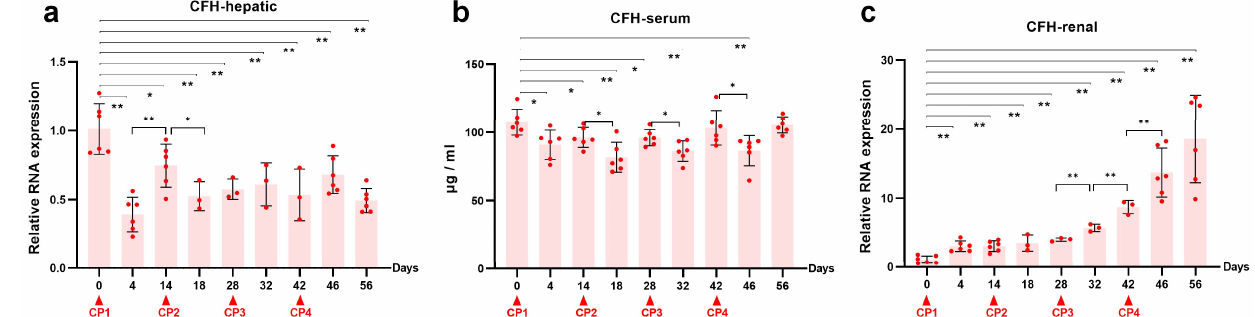
Figure 4. CFH expression during cisplatin (CP)-induced AKI-to-CKD transition in rats. Relative expression of CFH mRNA in ( a ) liver and ( c ) kidney after normalization with GAPDH. ( b ) Quantification of serum CFH level by ELISA with a 500-fold dilution of serum. Data are presented as means ± SD. * p < 0.05 and ** p < 0.01 between the two groups.